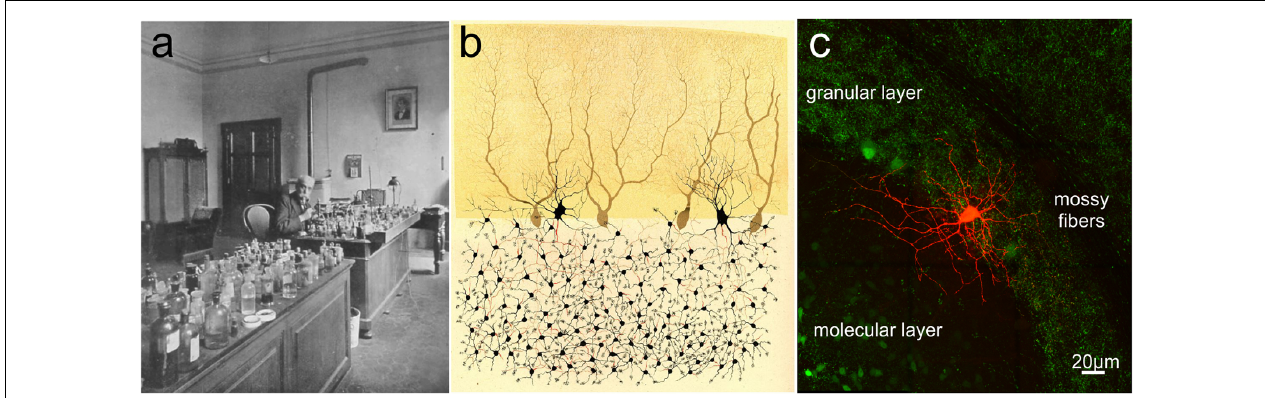
FIGURE 3 | Camillo Golgi and the cerebellar cortex. (A) Camillo Golgi in his laboratory at the University of Pavia. (B) Illustration by Camillo Golgi of a Golgi impregnated preparation of the cerebellum. Taken from Golgi (1883; available via license CC BY 4.0). (C) The current high-resolution rendering of a Golgi cell filled with a fluorescent dye and imaged with a two-photon microscope (courtesy of J. DeFelipe).